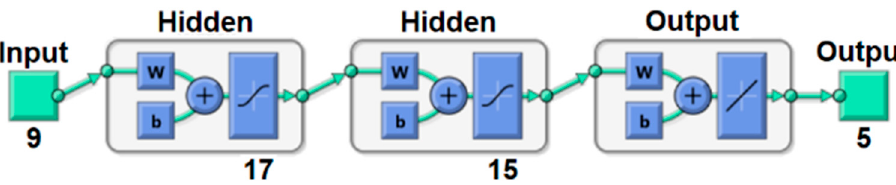
Figure 12. ANN structure of model F.